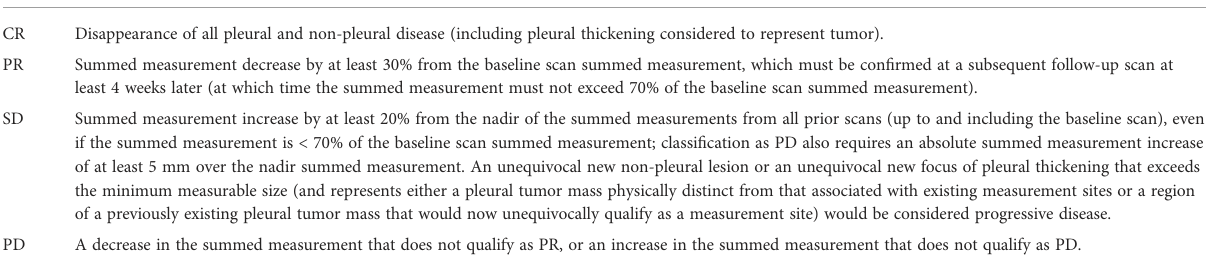
TABLE 2 Response Evaluation Criteria in Solid Tumors (RECIST